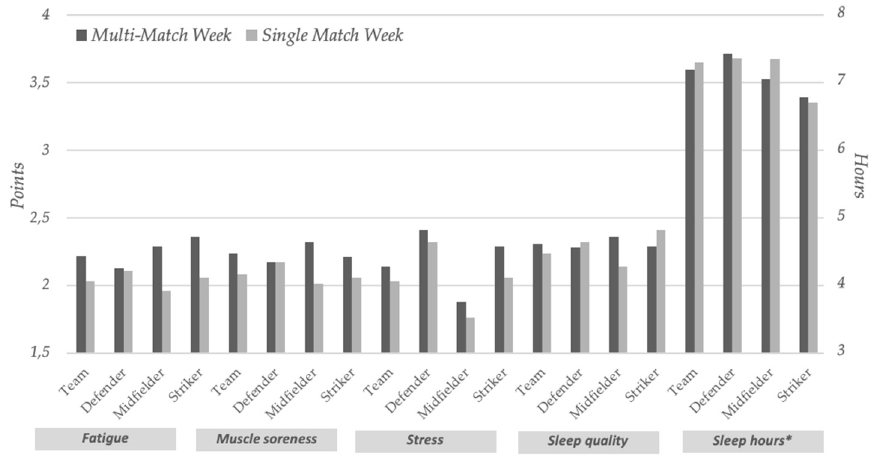
Figure 2. Wellbeing questionnaire data in multi-match vs. single-match weeks in soccer players that completed more than 60 min in the game and according to player position. (*) The sleep hours are represented on the right axis.